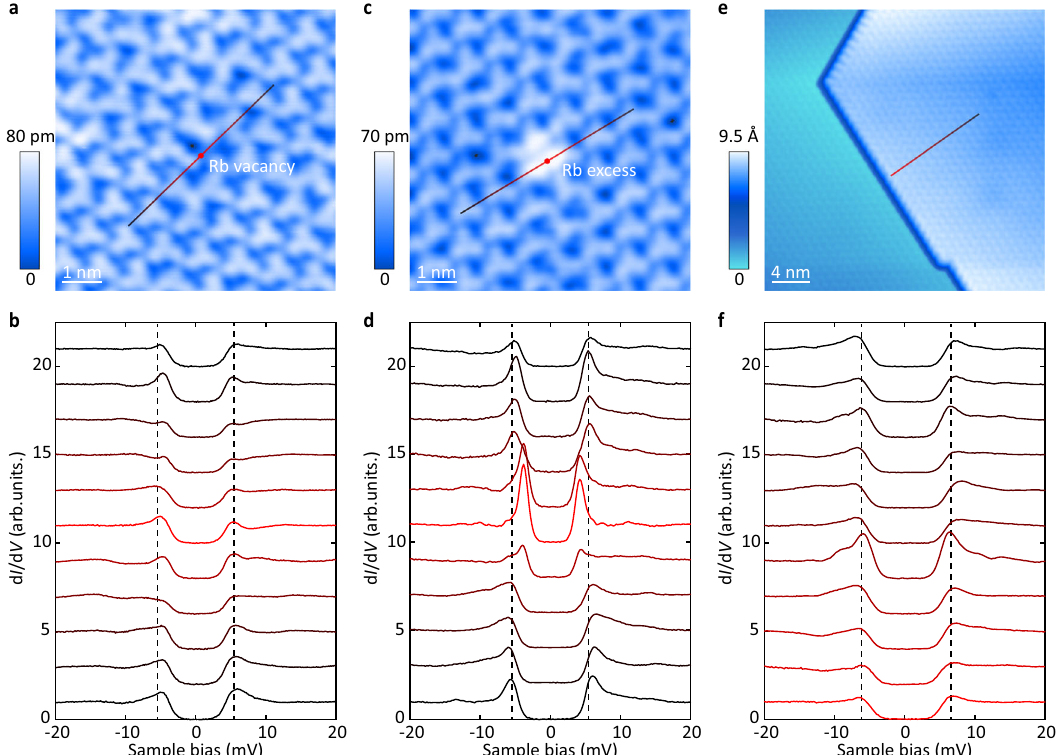
Fig. 3 Immunity of fulleride superconductivity to non-magnetic impurities. a , b High-resolution STM topography (7 nm × 7 nm, V = 1.0 V, I = 20 pA) of a single Rb vacancy (red dot) and tunneling spectra acquired 0.5 nm apart along the colored line in a . c , d STM topography (7 nm × 7 nm, V = 1.0 V, I = 20 pA) of a single Rb excess impurity (red dot) and tunneling spectra acquired 0.5 nm apart along the colored line in c . e , f STM topography (30 nm × 30 nm, V = 1.0 V, I = 20 pA) of Rb 3 C 60 fi lms with a monomolecular step edge and tunneling spectra acquired 1.3 nm apart along the colored line in e . The tunneling spectra are color-coded to match the probed positions near (red) and away from impurities (black). The tunneling gap is set at V = 30 mV and I = 200 pA. Note that two different color gradients are used in a , c , and e .